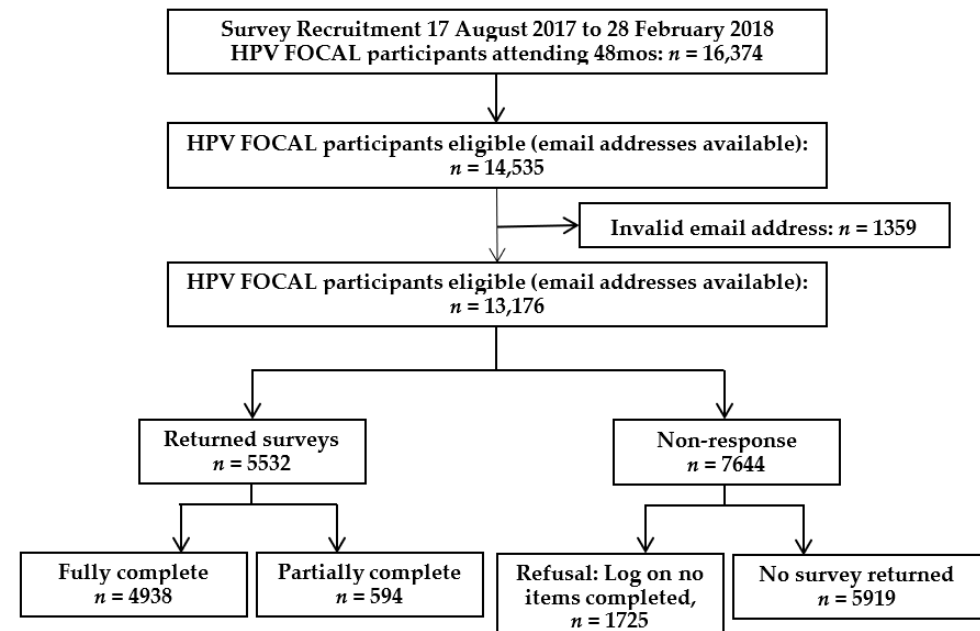
Figure 1. Study flow chart.